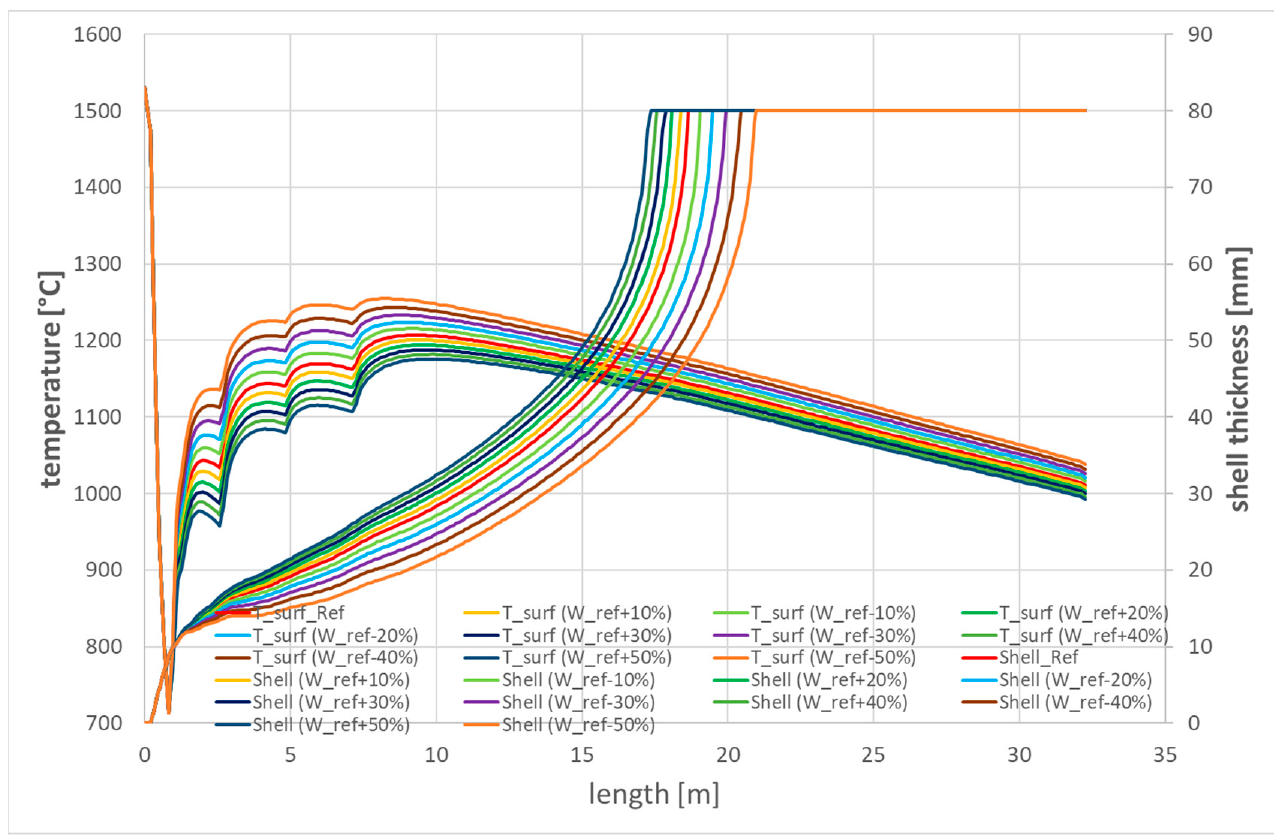
Figure 12. Surface temperature and shell thickness for the middle of the strand top side simulated with DynSolidCC for billet casting at ESF with stationary reference casting conditions and variation of secondary spray water flows between 50% and 150% compared to defined reference case.